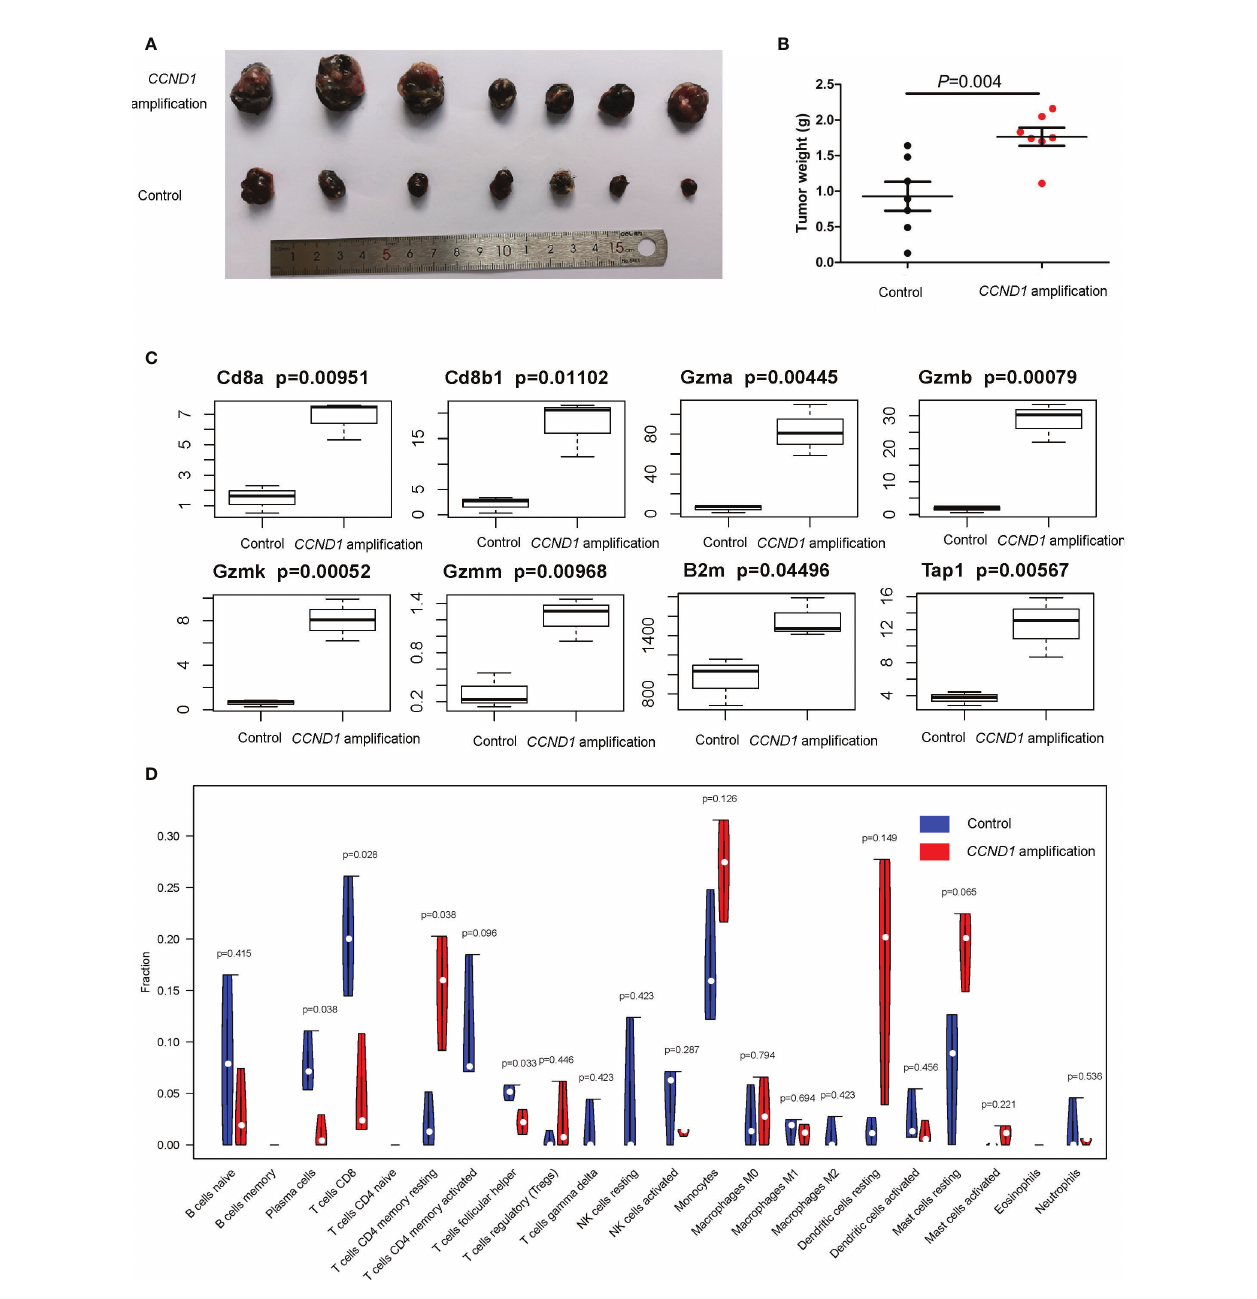
FIGURE 6 | Mice models of melanoma with CCND1 ampli fi cation interrogating the associated immune microenvironment. (A) Tumor appearance in each mouse was photographed. (B) The tumors were weighed 24 days after transplant. (C) Expression of CD8a, CD8b1, Gzma, Gzmb, Gzmk, Gzmm, B2m and Tap1 in CCND1 ampli fi cation tumor tissues and controls measured using RNA-seq ( n =3), error bars represent ± standard deviation. (D) The relationship between CCND1 ampli fi cation status and immune in fi ltration of 22 immune cell subsets using the CIBERSORT ( n